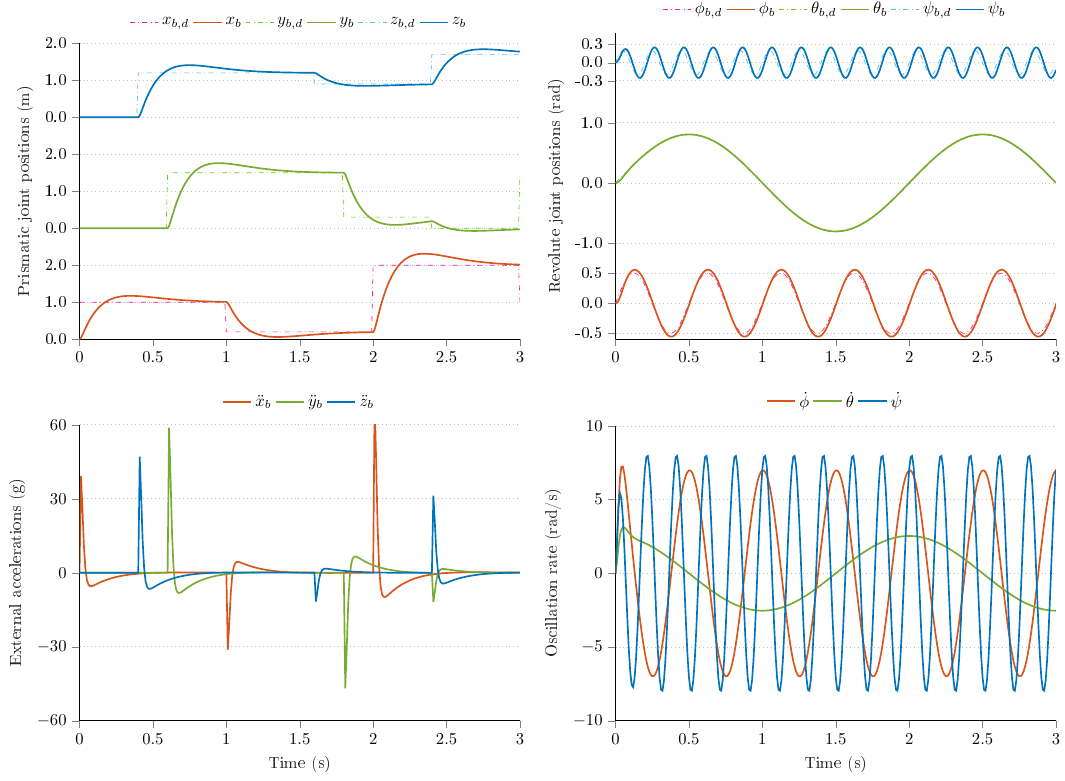
Figure 3. Reference tracking performance of the 6 DOF test bench in closed-loop. The right side of the first row highlights the performance of actuated revolute